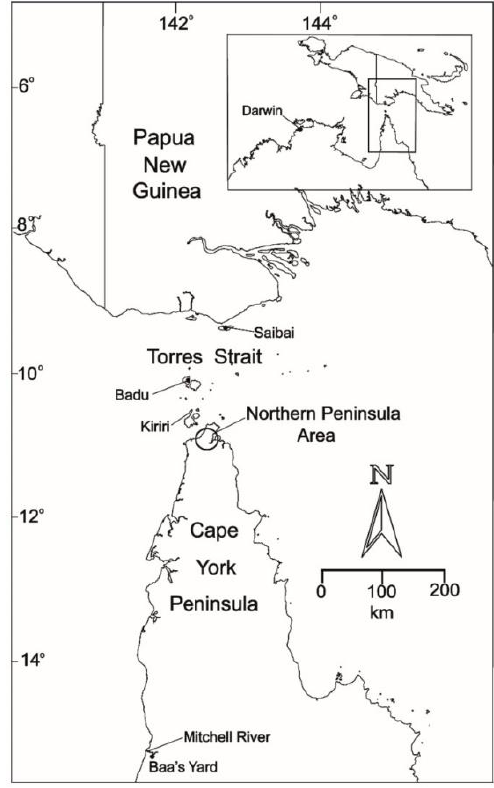
Figure 2. Map of Northern Australia and southern Papua New Guinea with the islands of the Torres Strait showing the areas referred to in the text of JEV incursions between 1995–2004. Reproduced from van den Hurk et al. [43].